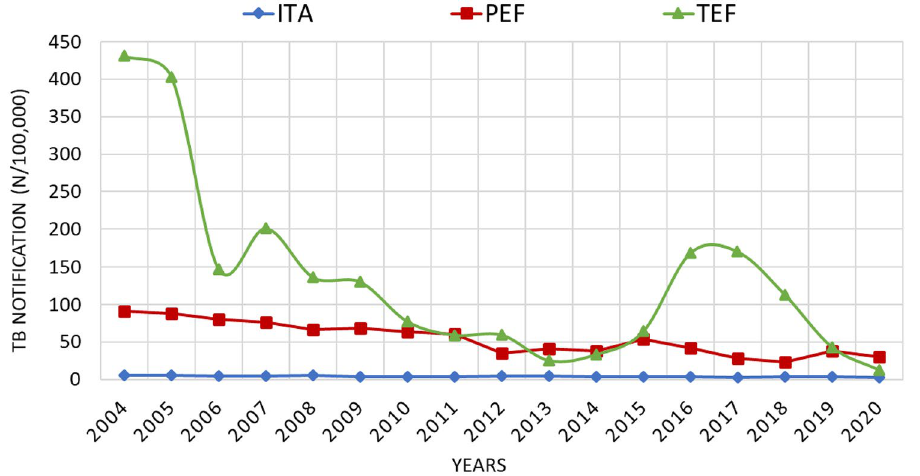
Figure 1. Trend of TB notification among ITA, PEF, and